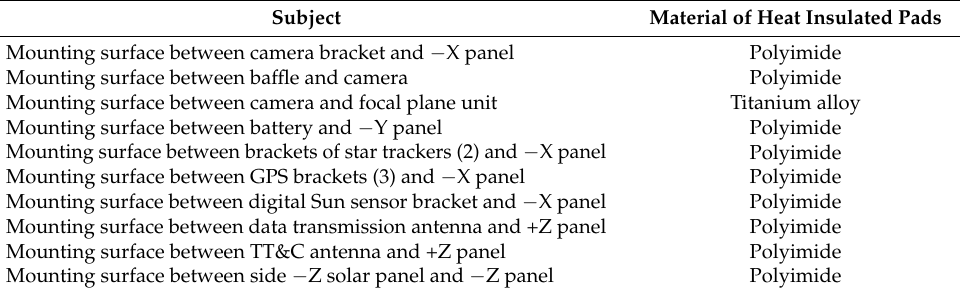
Table 9. Description of instruments mounting surfaces using heat insulated pads.